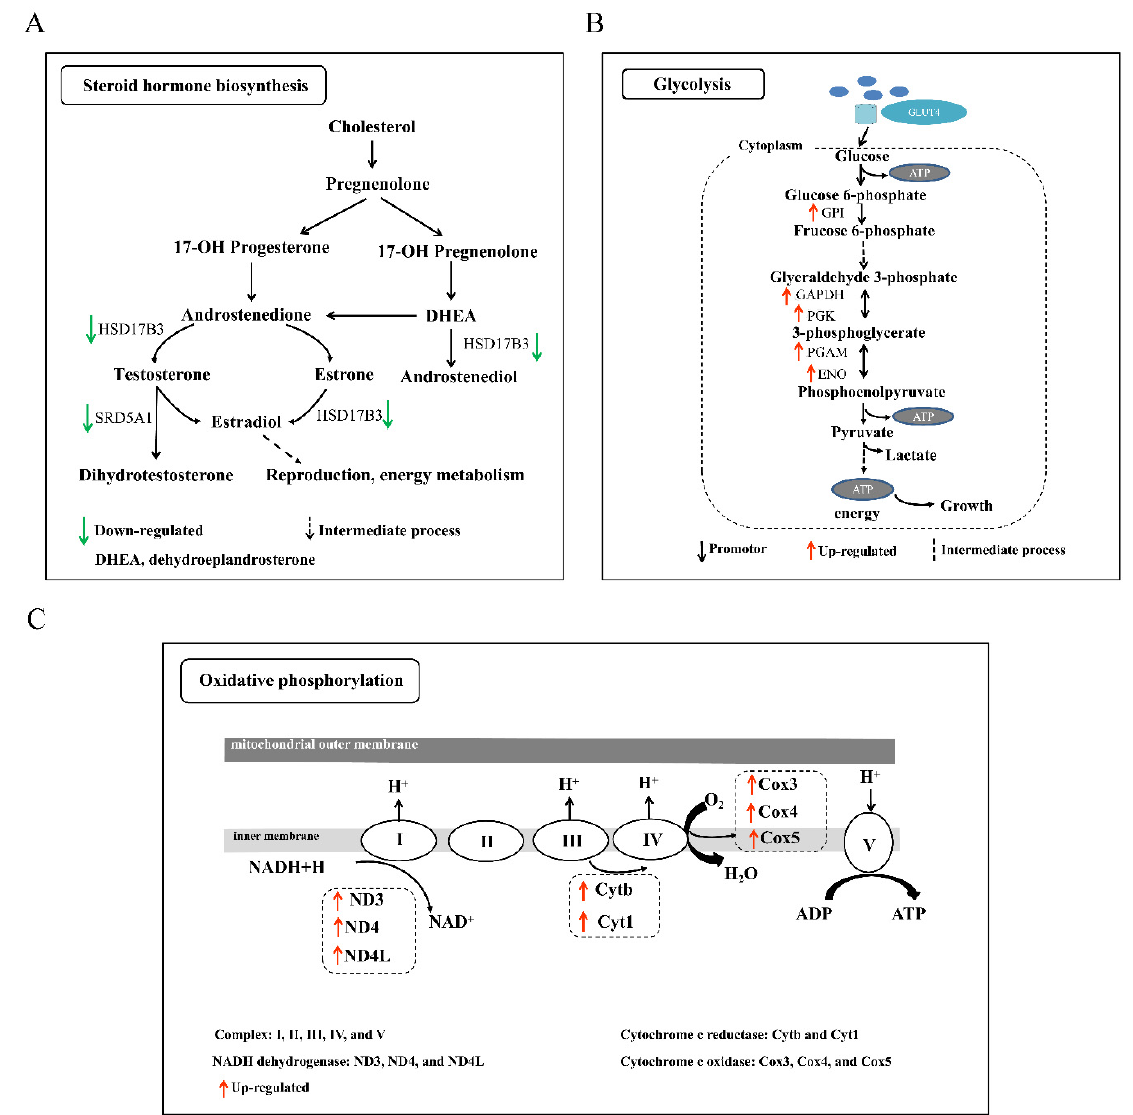
Figure 5. The schematic diagram of key pathways. ( A ) Steroid hormone biosynthesis. Note: HSD17B3, hydroxysteroid 17- beta dehydrogenase 3; SRD5A1, 3-oxo-5-alpha-steroid 4-dehydrogenase 1; DHEA, dehydroepiandrosterone. ( B ) Glycolysis. Note: GPI, glucose-6-phosphate isomerase; GAPDH, glyceraldehyde 3-phosphate dehydrogenase; PGK, phosphoglycerate kinase; PGAM, 2,3-bisphosph-oglycerate-dependent phosphoglycerate mutase; ENO, enolase. ( C ) Oxidative phosphorylation pathway. Note: I, II, III, IV, and V represent different complexes. ND3/4/4L, NADH-ubiquinone oxidoreductase chain 3/4/4L; Cytb/1, ubiquinol-cytochrome c reductase cytochrome b/1; Cox3/4/5, cytochrome c oxidase subunit 3/4/5. The green arrow represents the downregulated, and the dotted arrow represents the intermediate process. The black and red arrow represents the promotor and upregulated DEGs, respectively.